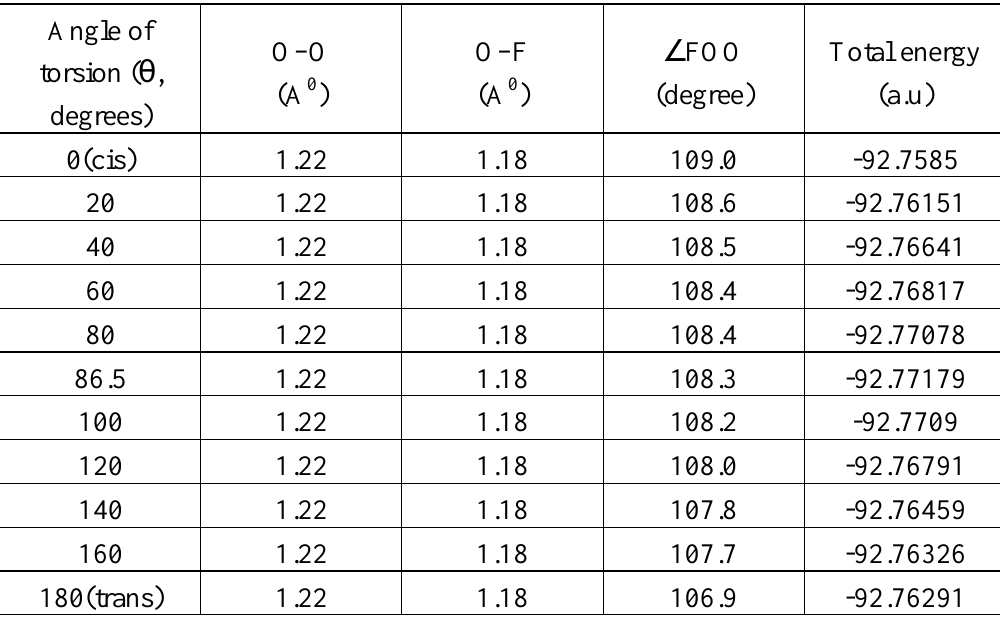
F as a function of torsional 2 2